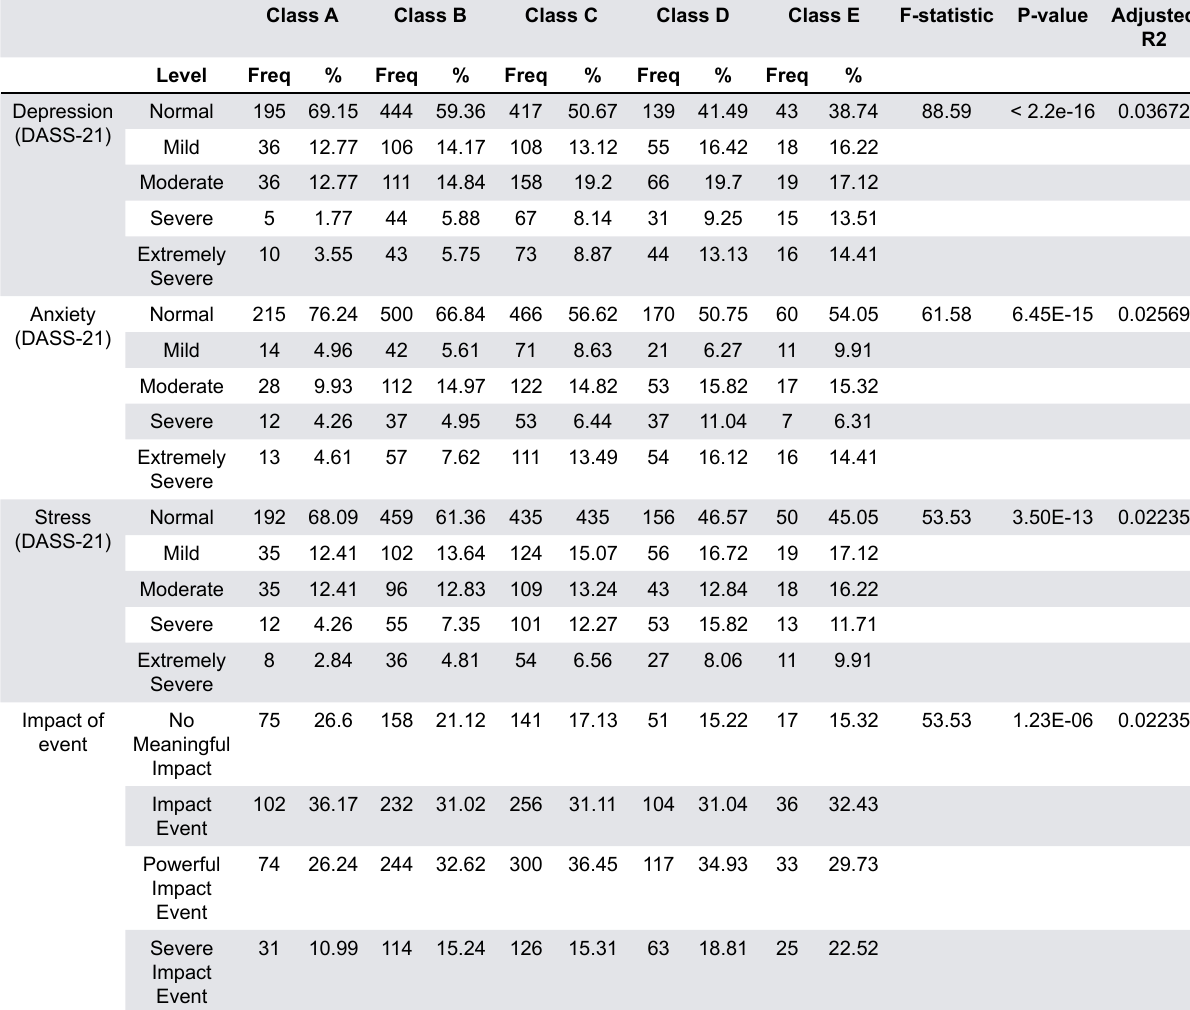
Impact event and orofacial pain amid the COVID-19 pandemic in Brazil: a cross-sectional epidemiological Table 5- Associations between social class, DASS-21 subscales and impact of the event (IES)